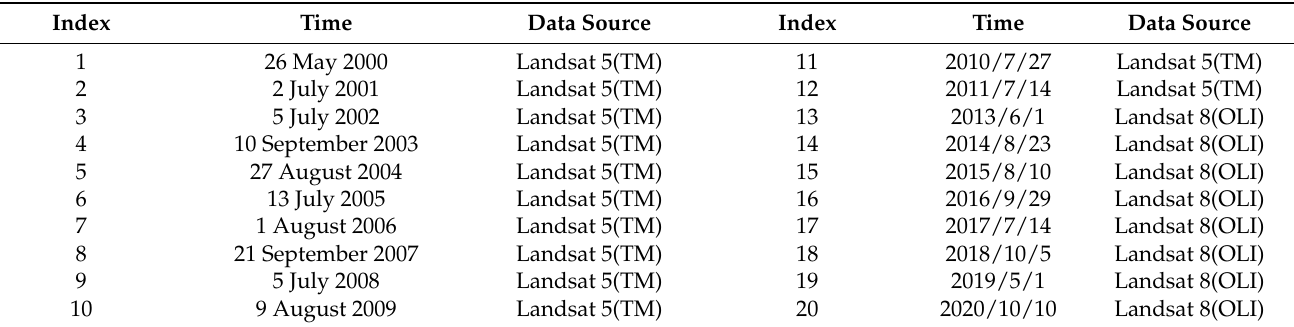
Figure 2. Changes in the surface area of Tuosu Lake in 2003 and 2020. Black error bar represents the uncertainty of the extracted lake surface area. Table 1. Sources of remote sensing data used in this